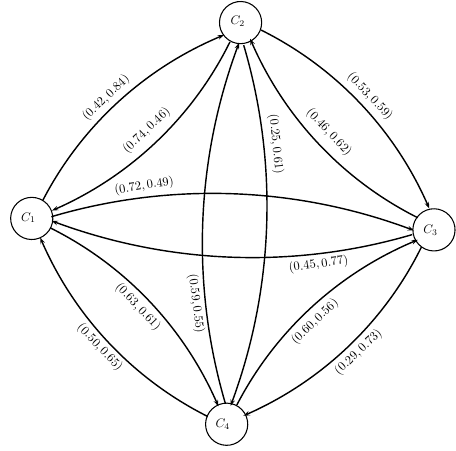
Figure 14. Directed network of the fused PFPR.